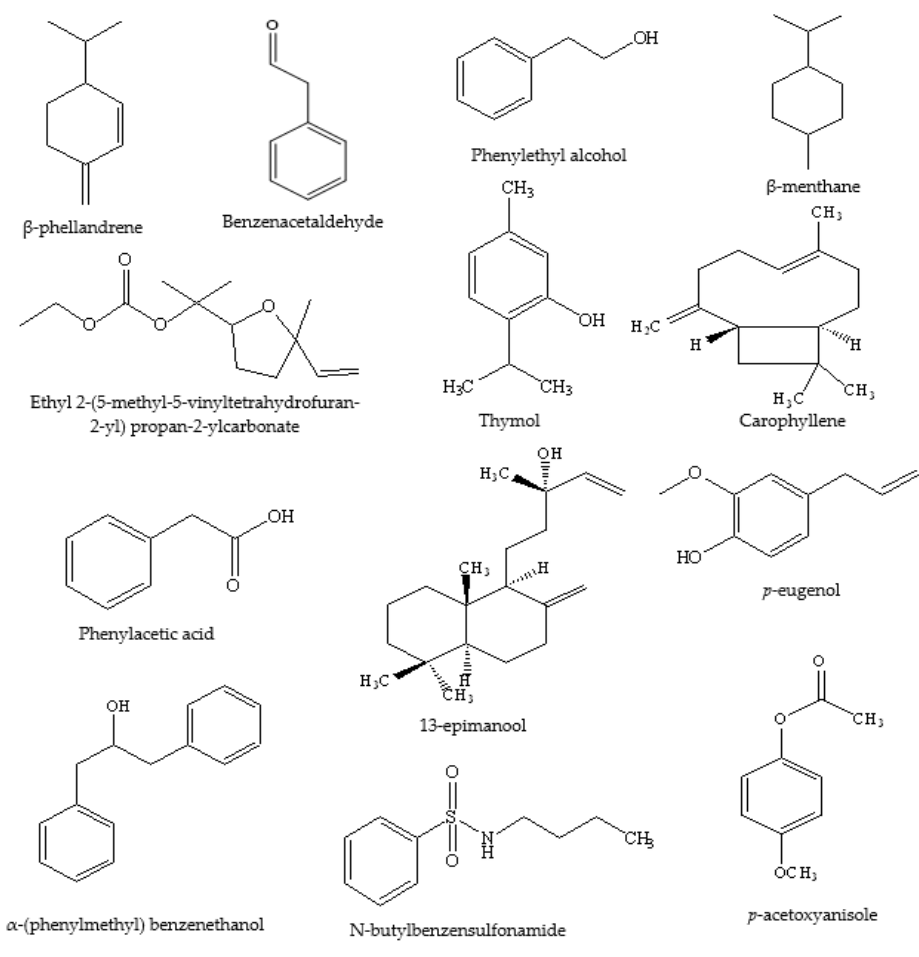
Figure 8. Volatile components found in Clover honey.